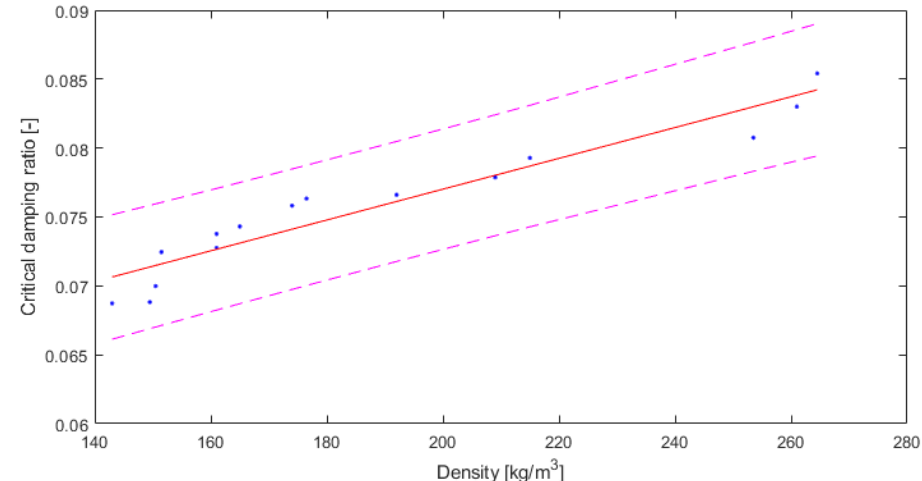
Figure 9. Results for critical damping ratio depending on density of material, with 95% confidence bounds (own elaboration).